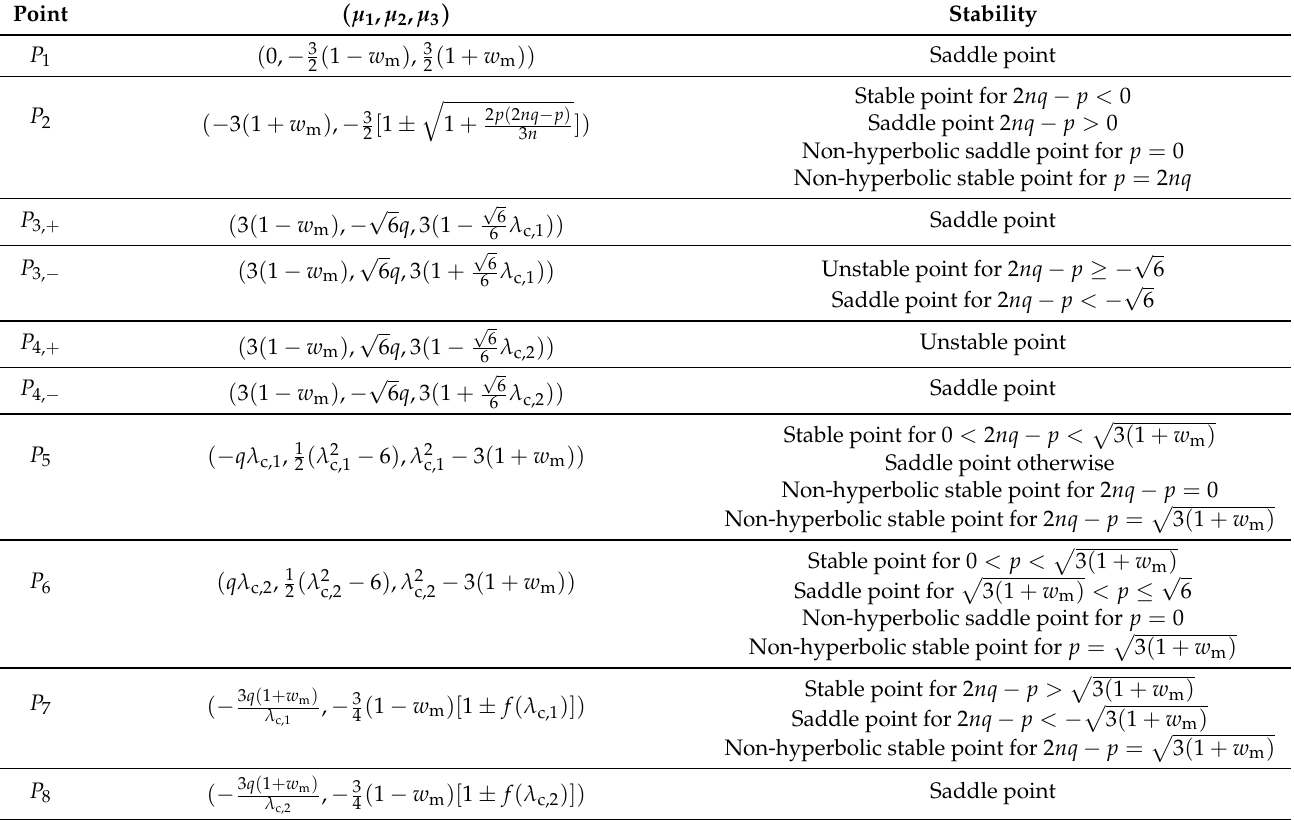
Table 4. Stability analysis for the dynamical system characterised by a broken power-law